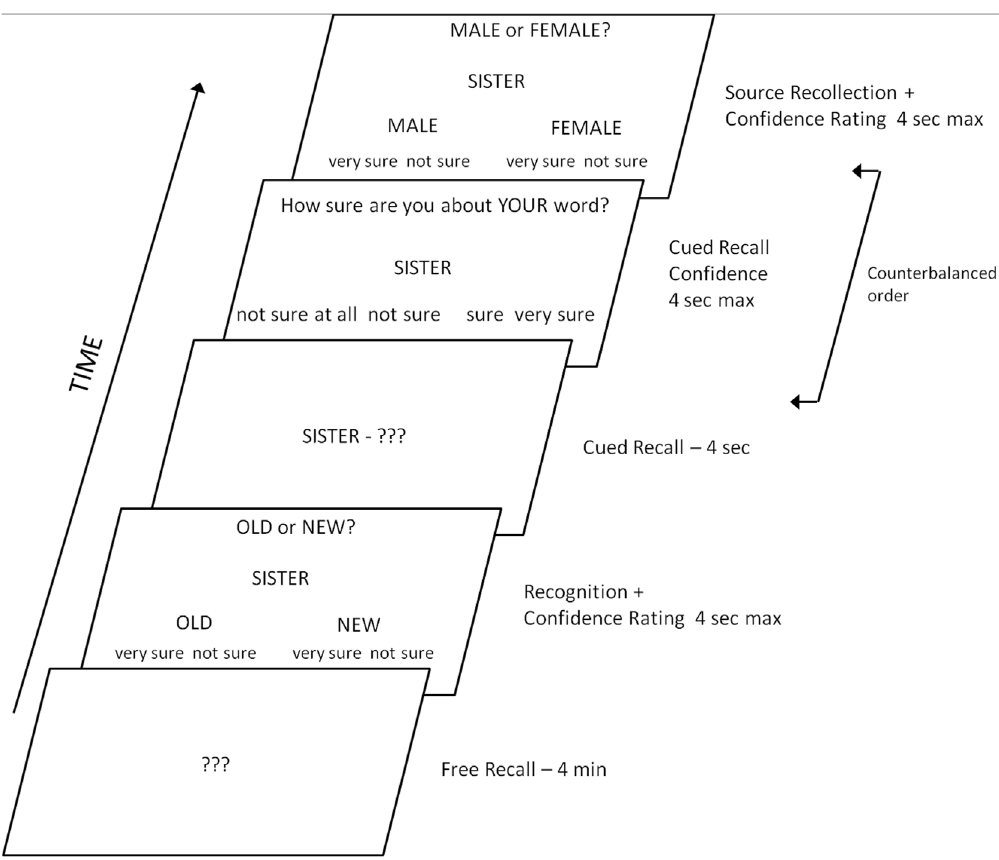
Figure 1. Schematic diagram illustrating the computerized memory tests.